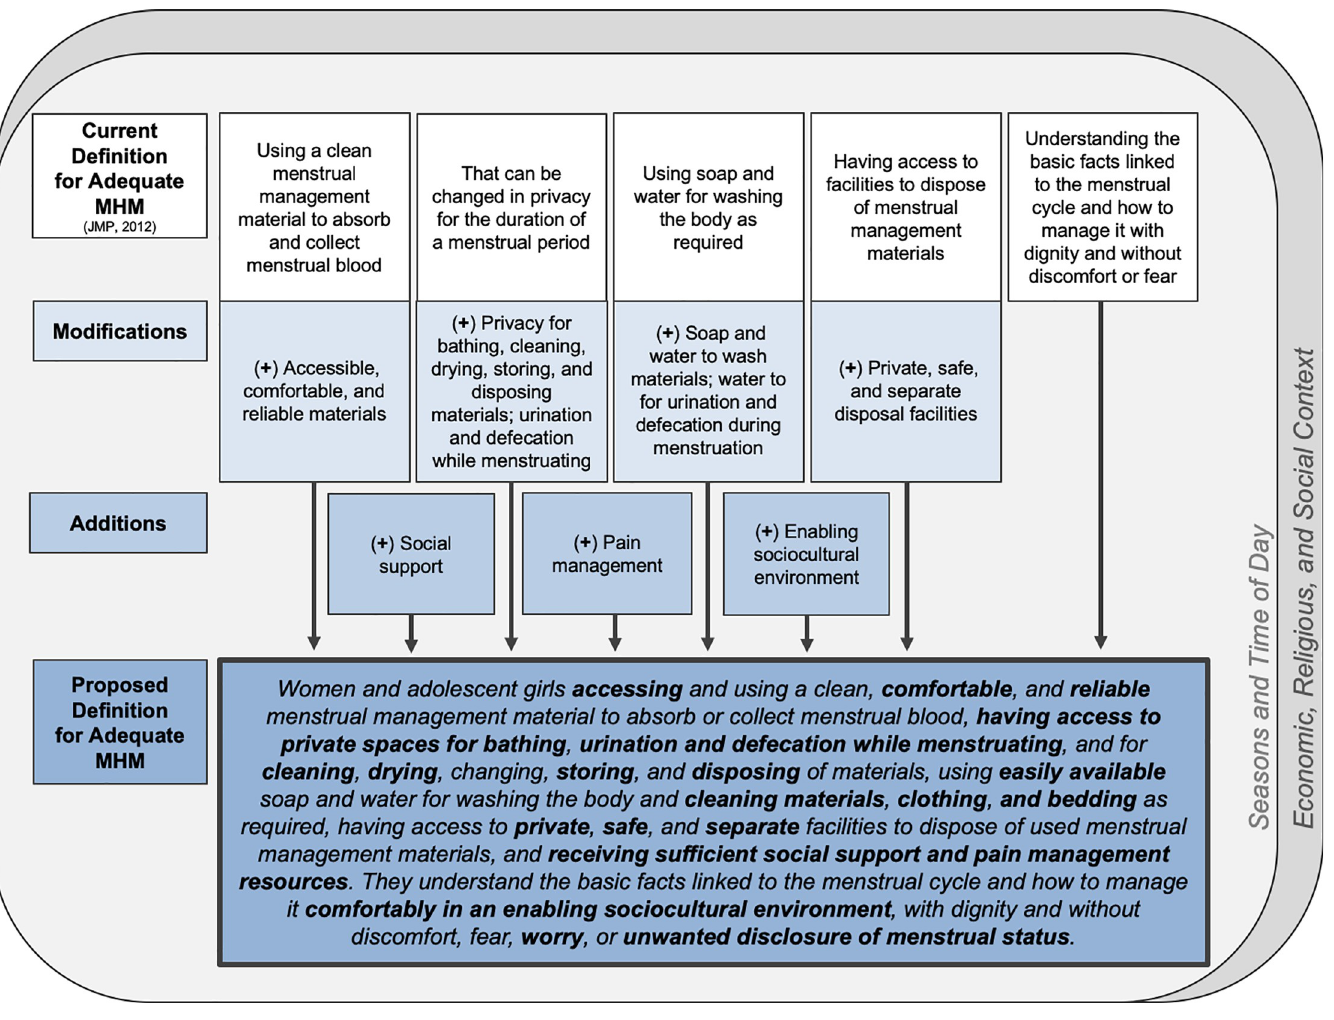
Fig 1. Conceptual framework of proposed definition for adequate menstrual hygiene management for women in Odisha, India.